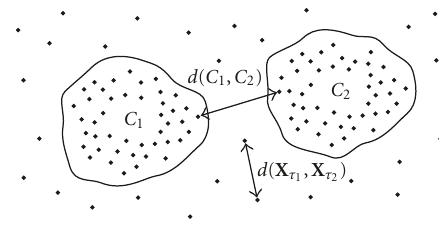
Figure 3: Illustration of distances.